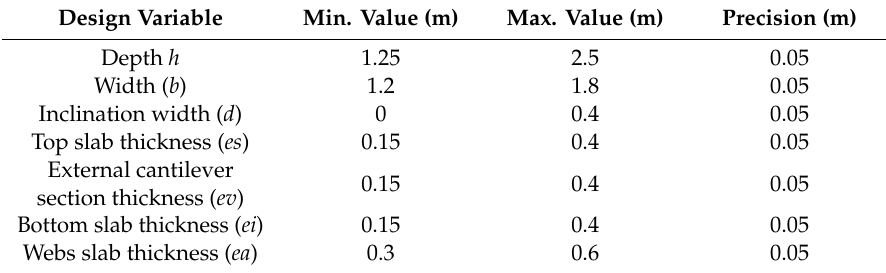
Figure 3. Box-girder cross-section. Table 1. Main parameters of the analysis.